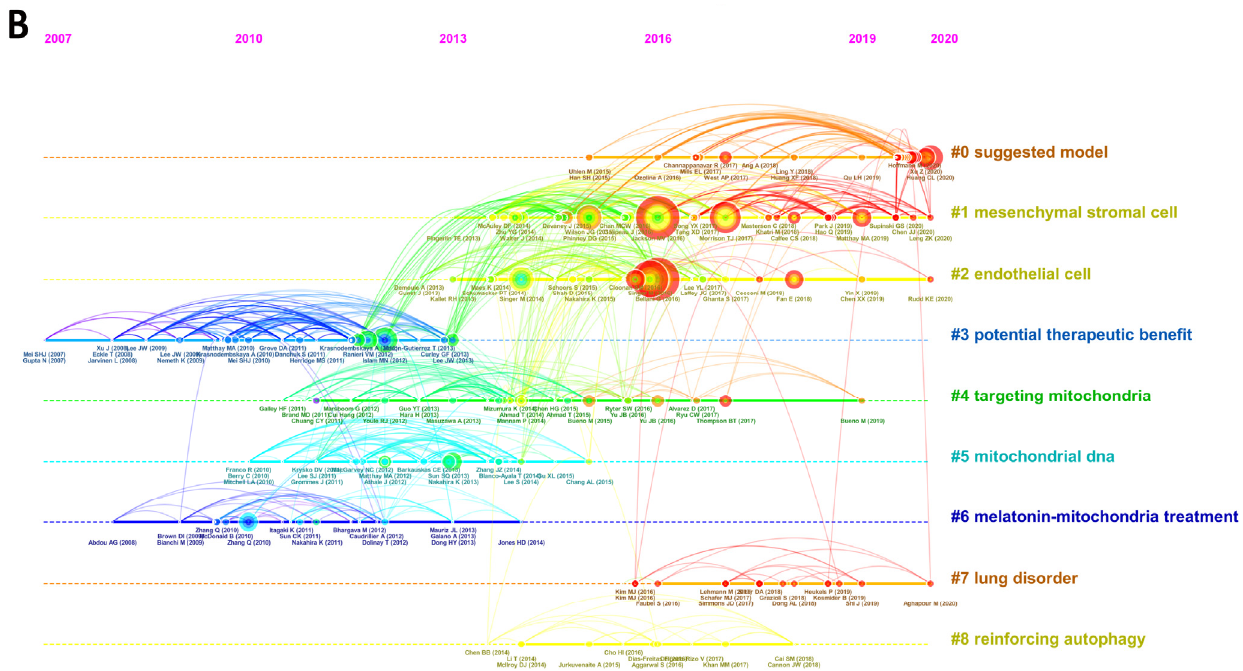
Figure 7. ( A ) The clustered network map of co-cited references related to mitochondria in ALI. Note: Each node represents a reference, and different colors represent different clusters. ( B ) The timeline view of co-citation clusters with their cluster-labels on the right. Note: Each node represents a reference, the size of the circle represents the citation frequency, and the red color of the circles and the connecting curves represents the latest year.